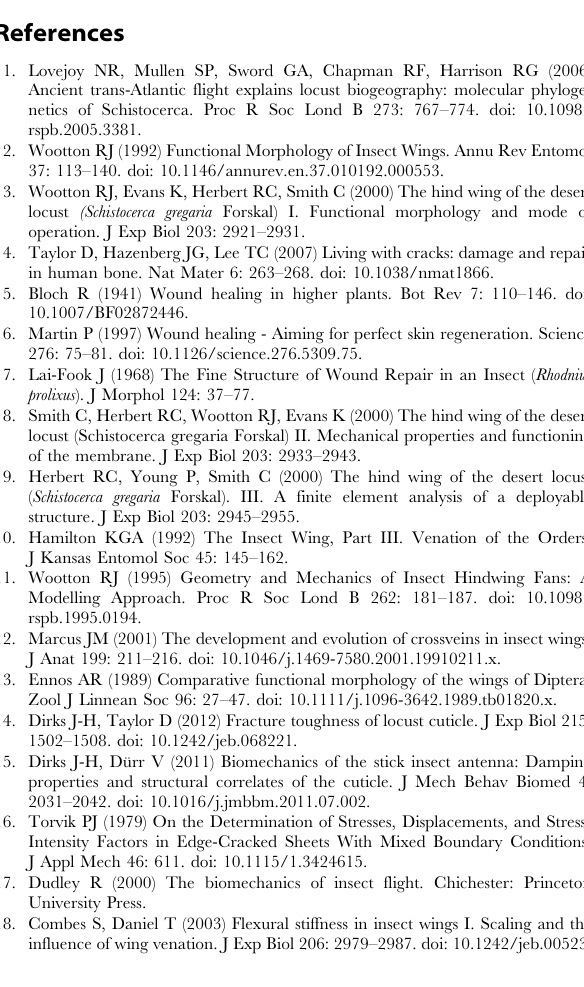
Figure S1 Comparison of locust wing patterns to dragonfly wings. (a) Size and distribution of wing cells in the hind wings of the recent dragonfly Sympetrum vulgatum (adapted from [35]) and the extinct Protolindenia viohli (fossil imprint from the upper Jurassic, adapted from [36]). The wing venation pattern of dragonflies barely changed within the last hundreds of millions of years [35,37]. (b) Both wings show a distribution of wing cells very similar to that of S. gregaria (same data as in Figure 3 b), with the P. viohli wing showing a higher number of smaller wing cells, in particular at the edge of the wing. The pterostigmata have been removed from the analysis. Figure S2 (video still) Propagation of a crack through a hind wing of S. gregaria under tension. At a certain stress the initial crack starts propagating through the membrane (K C0 ). When the crack hits a cross vein (subfigures b, c and d), the crack is delayed, which increases the fracture toughness of the wing (K C1 ). Numbers indicate frame number. (TIF) Video S1 (online only) Video of a manually induced crack propagating through a hind wing of S.